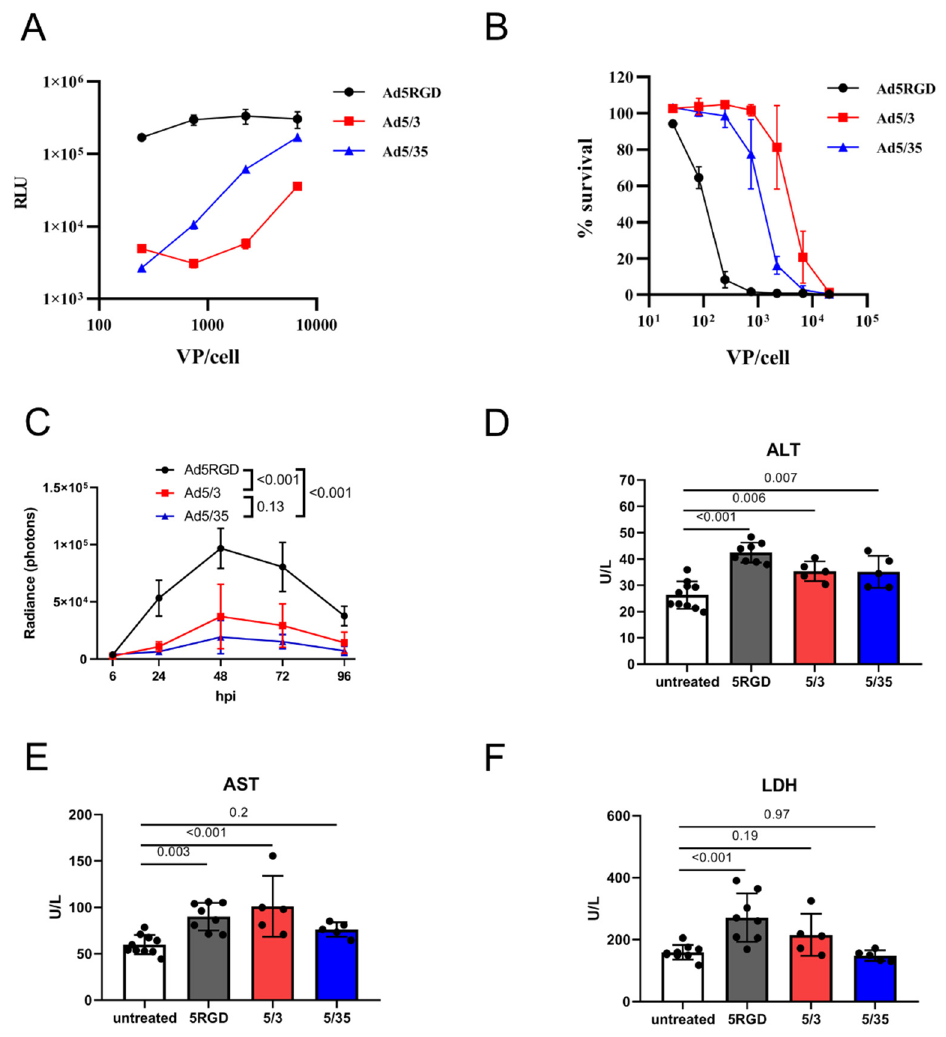
Figure 1. In vivo transduction of hepatocytes does not correlate with toxicity. ( A ). Transduction rates of Fluc-expressing adenoviral vectors in murine hepatocytes (AML12) measured by biolumi- nescent assay at 24 hpi; ( B ). Cytotoxicity of adenoviral vectors in murine hepatocytes (AML12) measured by AlamarBlue™ cell viability assay at 120 h after infection. For ( A , B ), the results of two independent experiments are plotted (mean ± SD); ( C ) In vivo liver transduction rates of i.v. injected Fluc-expressing adenoviral vectors (7 × 10 8 IFU) measured by bioluminescence at indicated time points ( n = 5; mean ± SD; p -values are shown on graph; two-way ANOVA followed by Tukey’s multiple comparisons test); ( D – F ). Plasma levels of ALT ( D ); AST ( E ); and LDH ( F ) measured at 12 h after i.v. administration of adenoviral vectors (7 × 10 8 IFU; mean ± SD; p -values are shown on graph; one-way ANOVA followed by Dunnett’s multiple comparisons test).